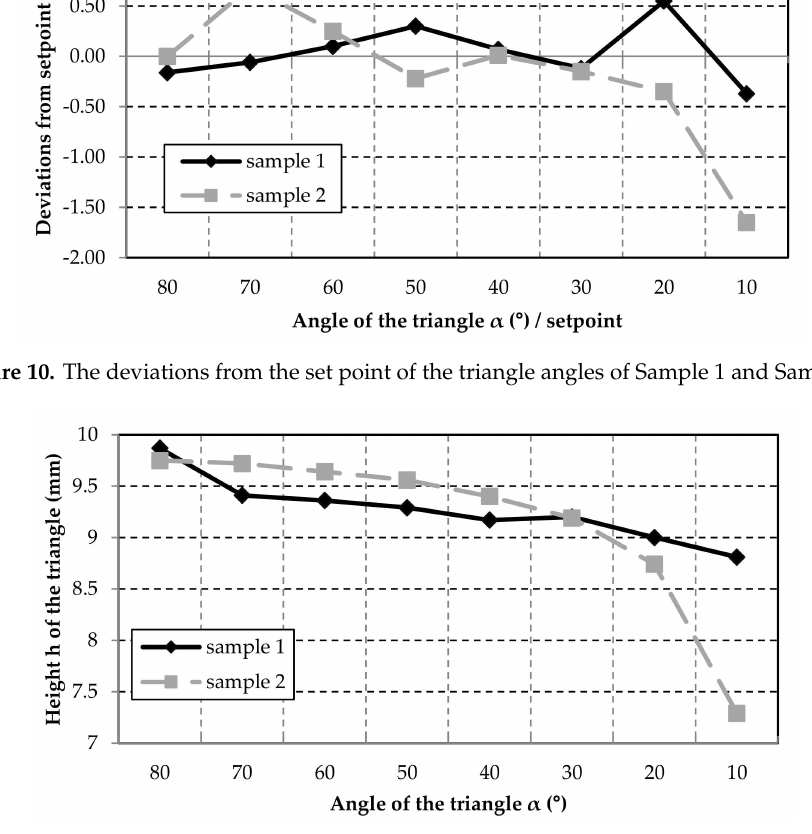
Figure 11. The height of the triangles of Sample 1 and Sample 2 at di ff erent angles. The set point of the height for all triangles is 10